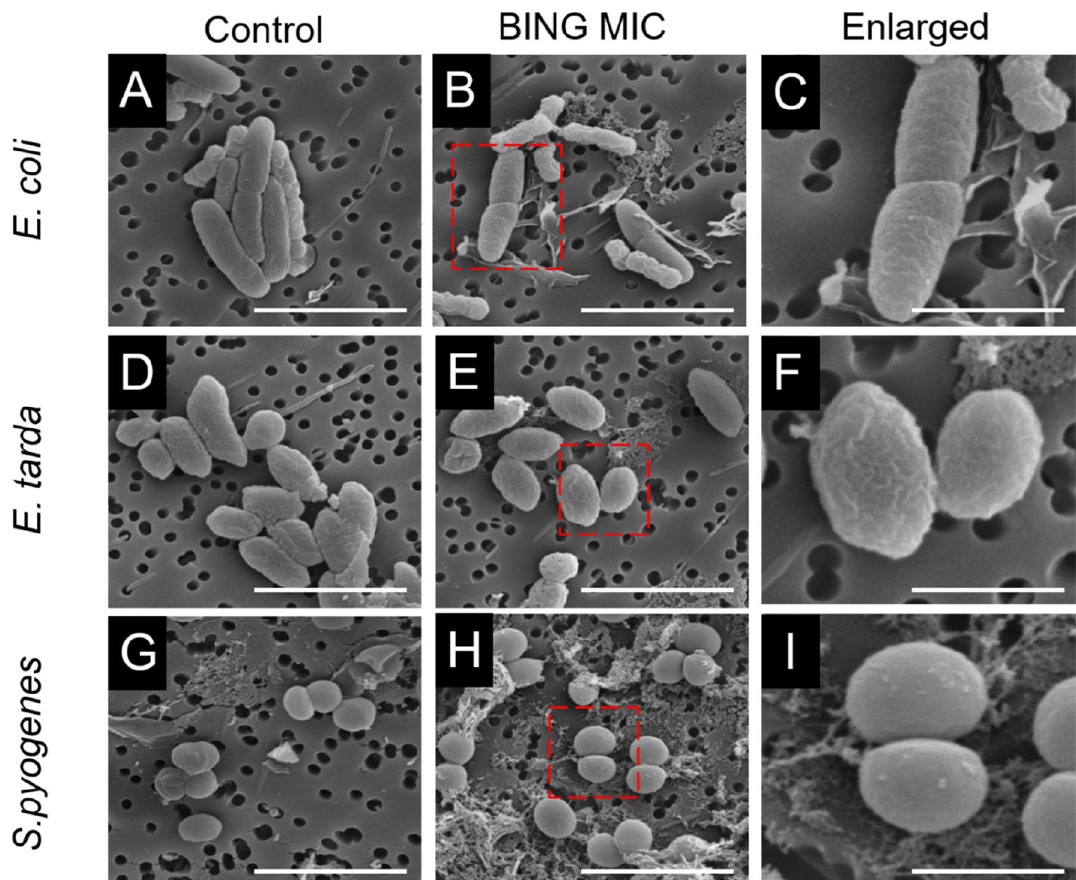
Figure 4. Scanning electron micrographs of E. coli ( A – C ) E. tarda ( D – F ) and S. pyogenes ( G – I ) incubated with BING (7.8 µg/mL for E. coli , 10 µg/mL for E. tarda and 50 µg/mL for S. pyogenes ) or culture medium for 1 h. Bars in panels ( A , B , D , E , G , H ): 3 µm. Bars in ( C , F , I ): 1 µm. Representative images from three replicates were